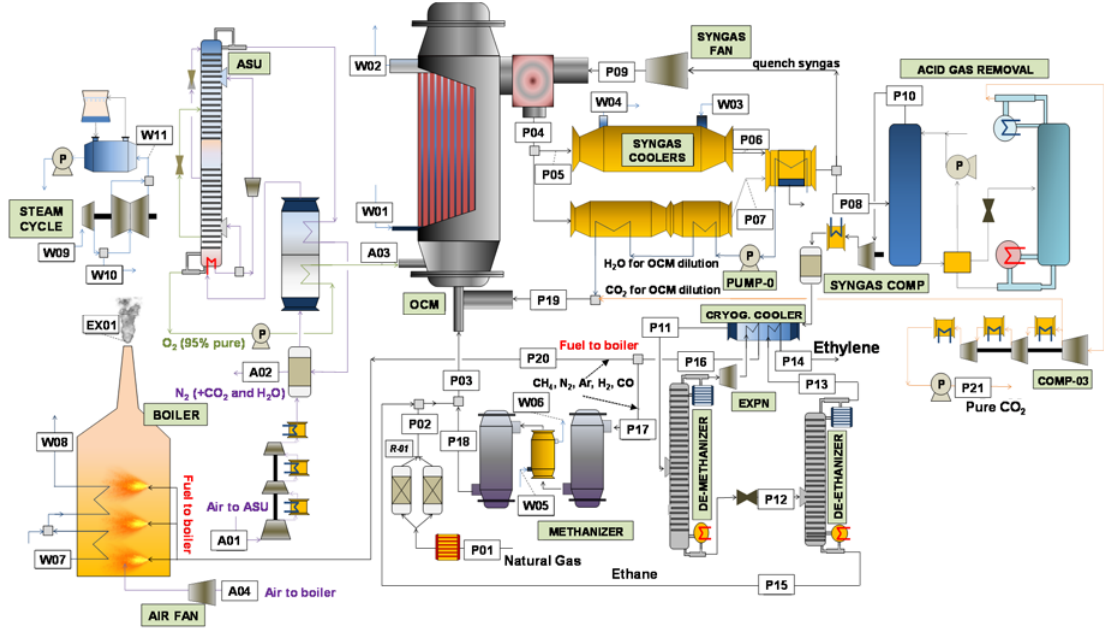
Figure 2. Porous membrane reactor OCM process flow diagram.